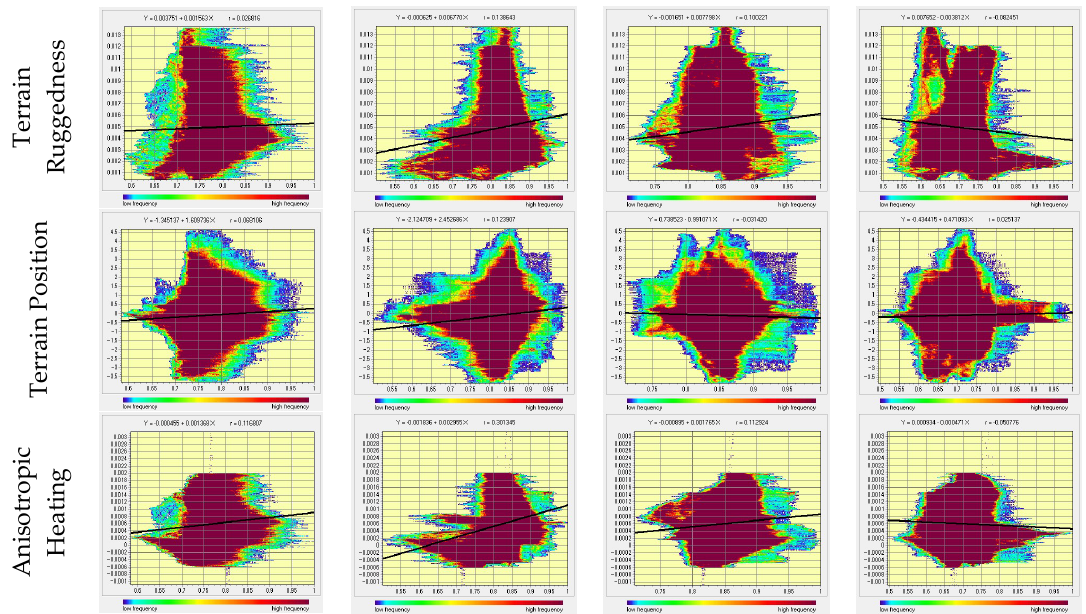
Figure 8. Regression analysis between the principal components and the topographic variables computed from the System for Automated Geoscientific Analysis (SAGA) GIS software.